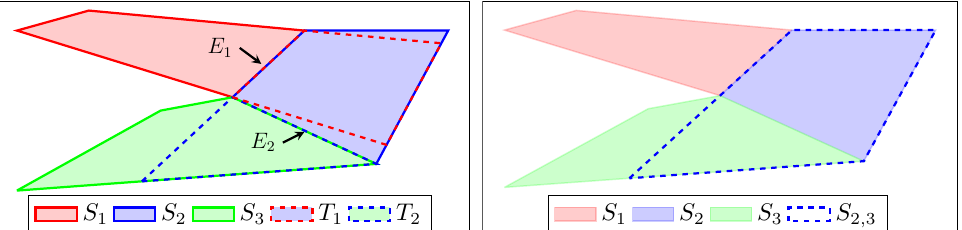
Figure 4. Illustration of connected polytopes, transition zones, and extended polytopes, according to Definitions 1 and